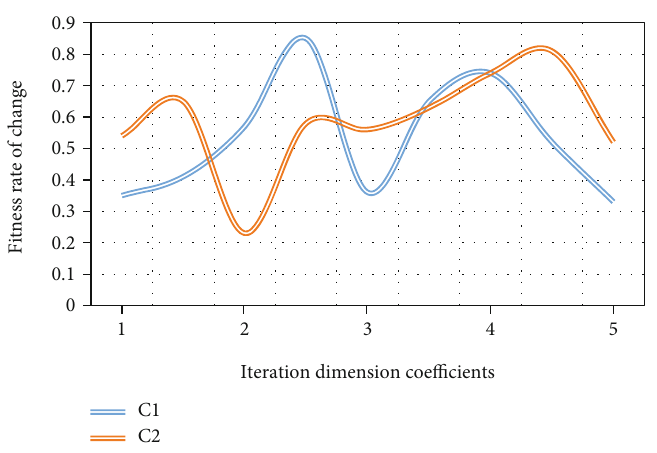
Figure 6: Iterative relationship diagram of fi tness change